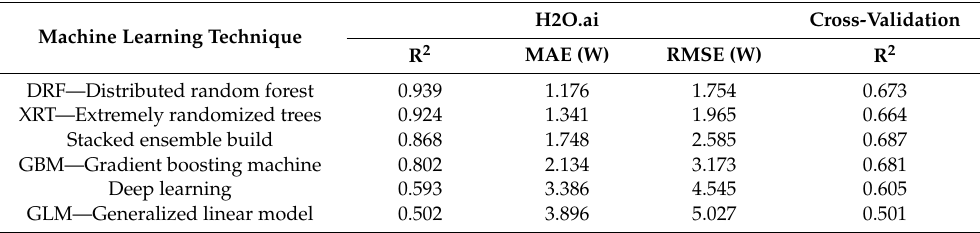
Table 4. H2O.ai and cross-validation modeling results.